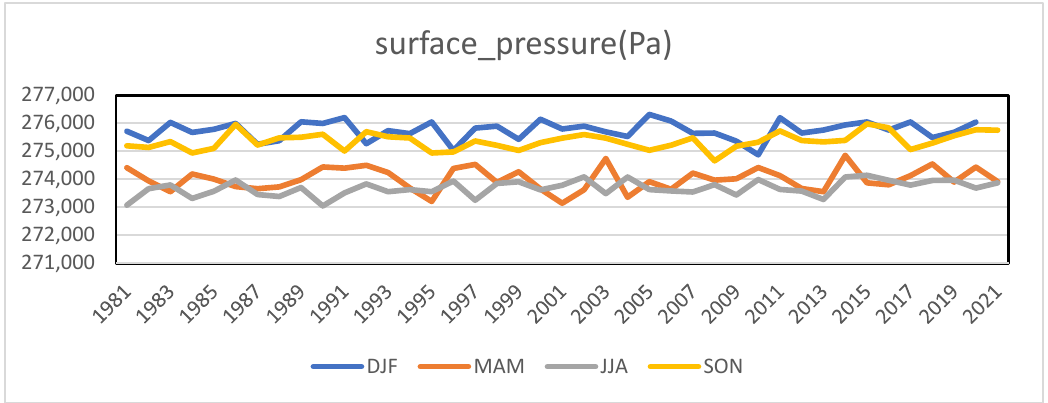
Figure 10. Yearly surface pressure.